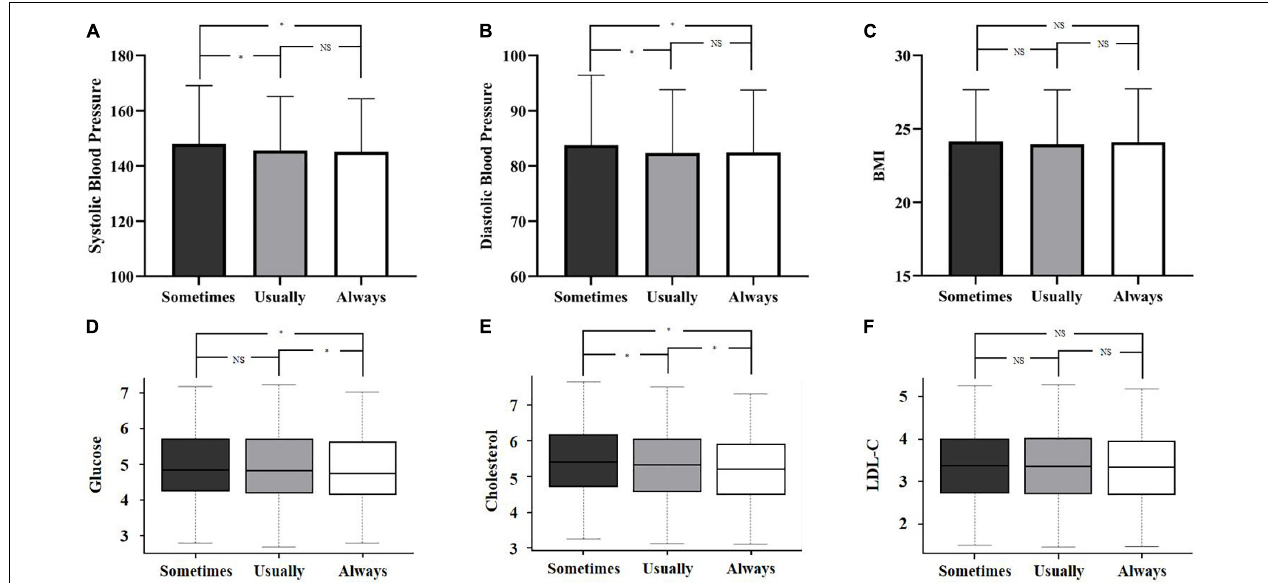
FIGURE 2 | Classic cardiovascular risk factors stratified by health check frequency. Differences in systolic blood pressure (A) , diastolic blood pressure (B) , BMI (C) , glucose (D) , cholesterol (E) , and LDL-C (F) between different health check frequencies. ∗ p < 0.05. NS, not significant; BMI, body mass index; LDL-C, low-density lipoprotein